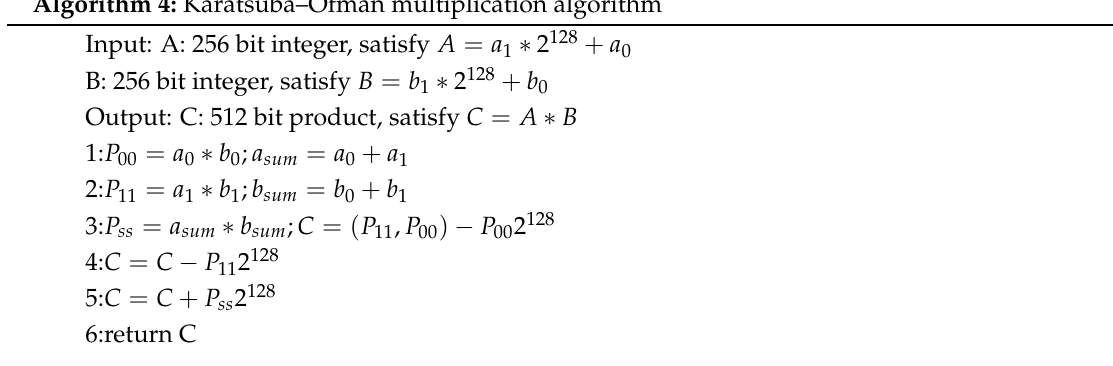
Algorithm 4: Karatsuba–Ofman multiplication